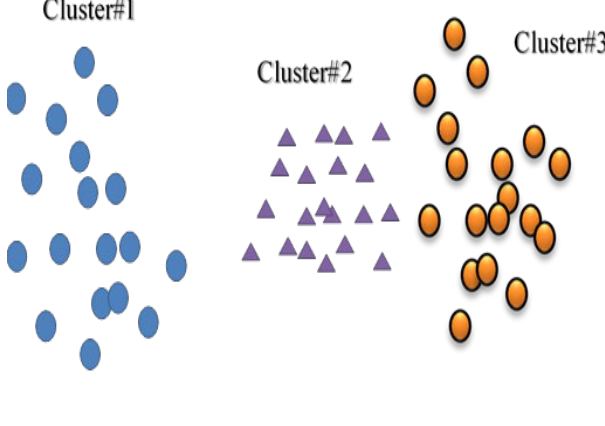
Figure 2. The landscape of three different clusters in coordinate